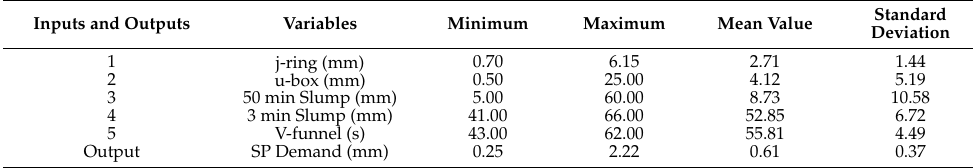
Table 6. Details of the input and output variables.